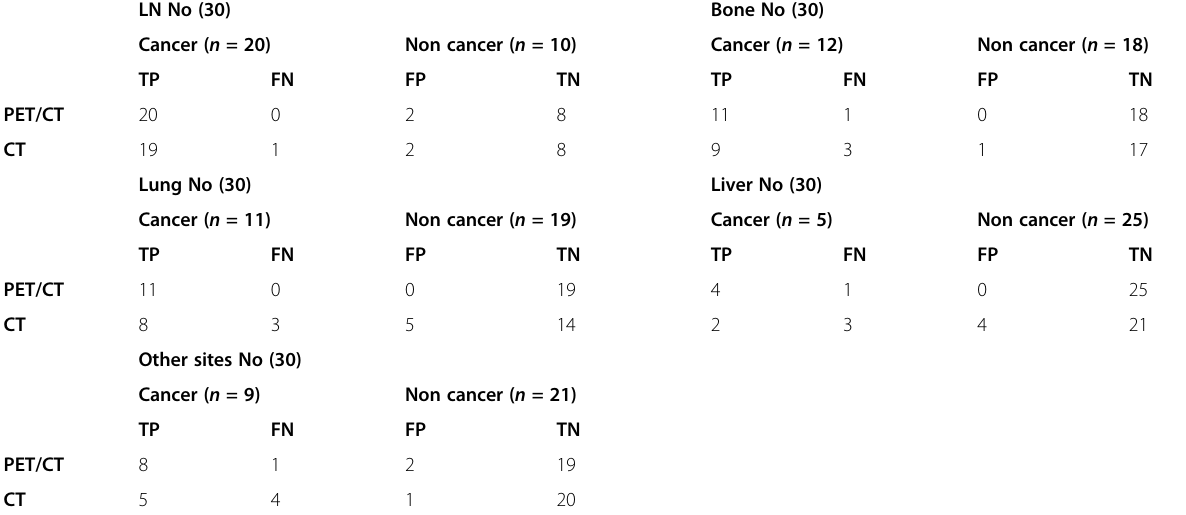
Table 4 Diagnostic rendering of PET/CT and contrast-enhanced CT in 30 patients with breast cancer to detect distant